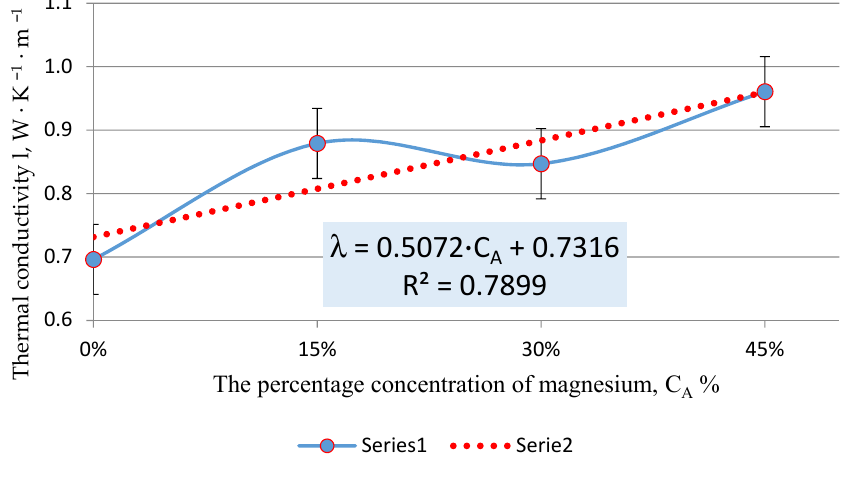
18.29 Table 4. Thermal conductivity test results for designs A, B and C. Test